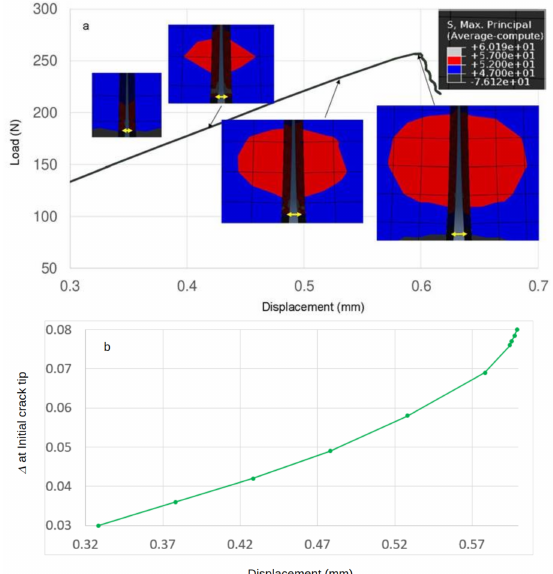
Figure 10. CZS prediction of the fracture process for D230 + 5 wt% MX-257. ( a ) Load vs. LLD, with the corresponding maximum principal stress (MAXPS) contours shown at various points. Yellow arrows indicate the degree of separation between the nodes at the initial crack tip. ( b ) Separation between crack faces at the crack tip vs.